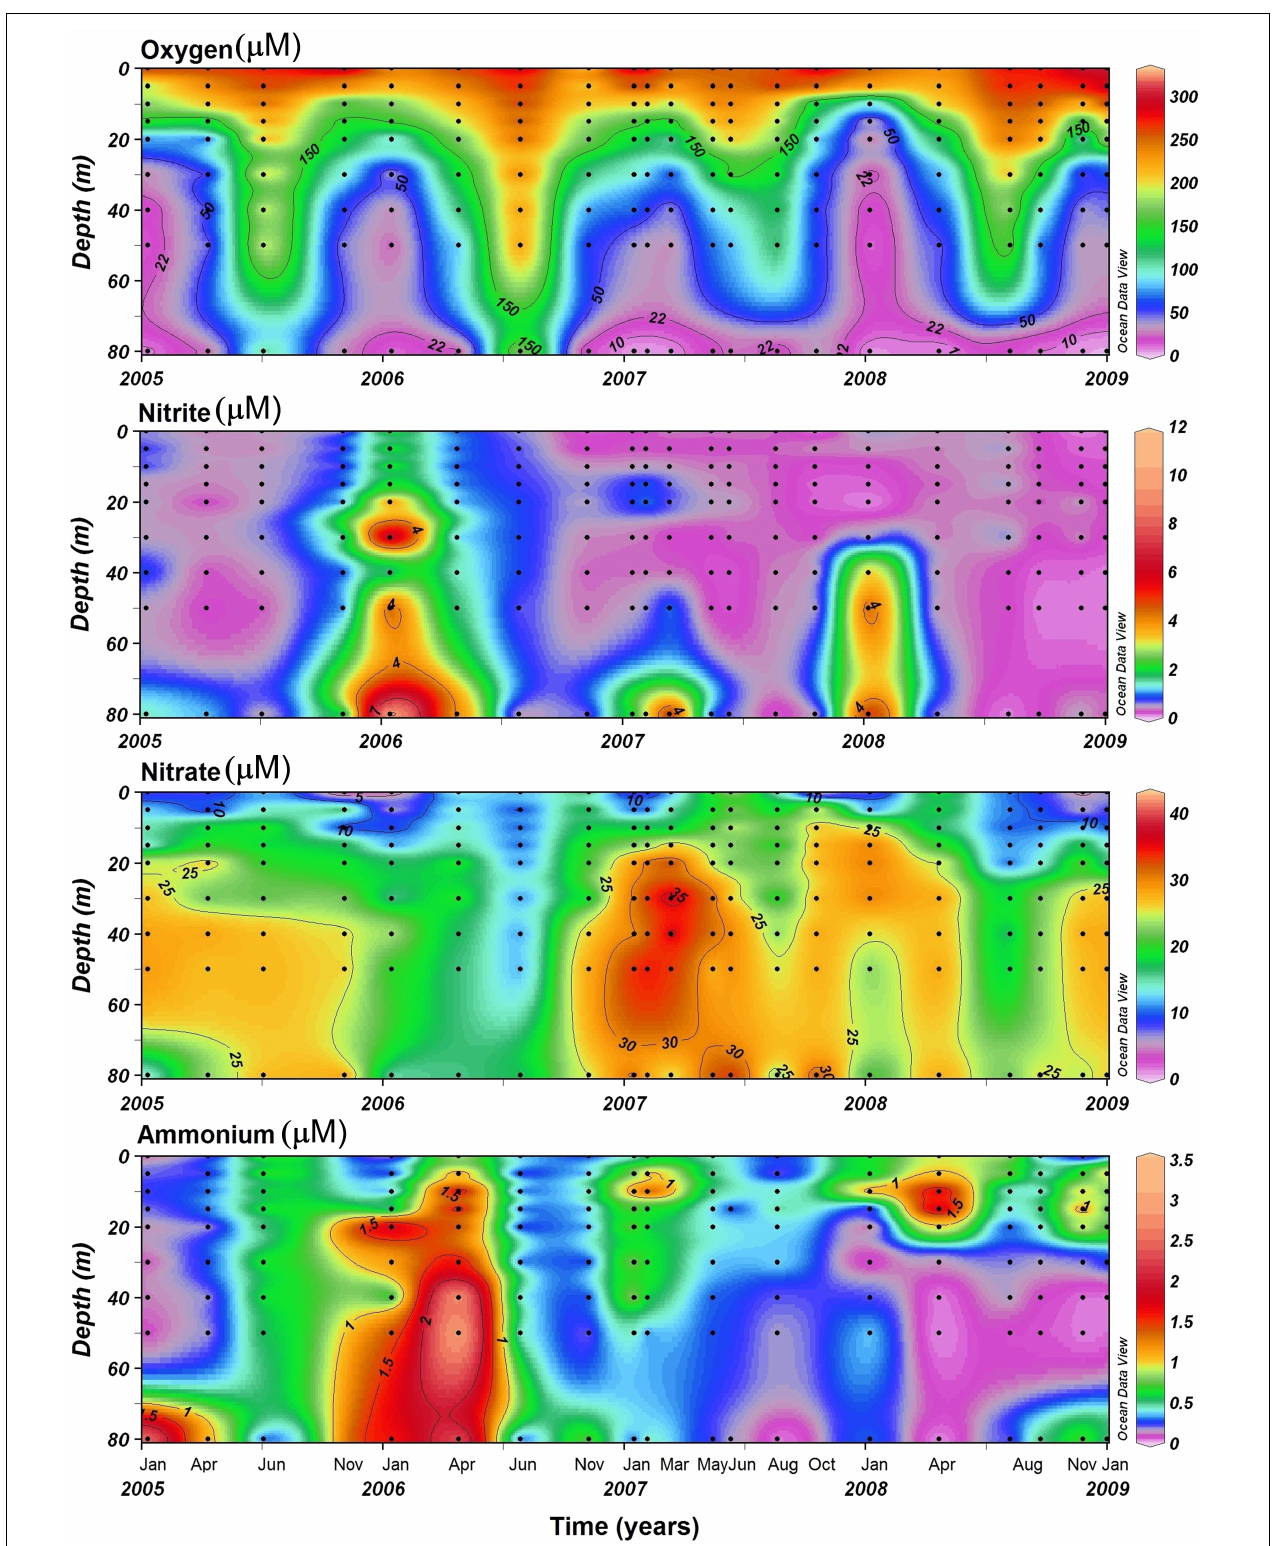
FIGURE 1 | Spatiotemporal variability of dissolved oxygen, ammonium, nitrite, and nitrate at the time series station (St.18). Dots indicate specific date and depth samplings.